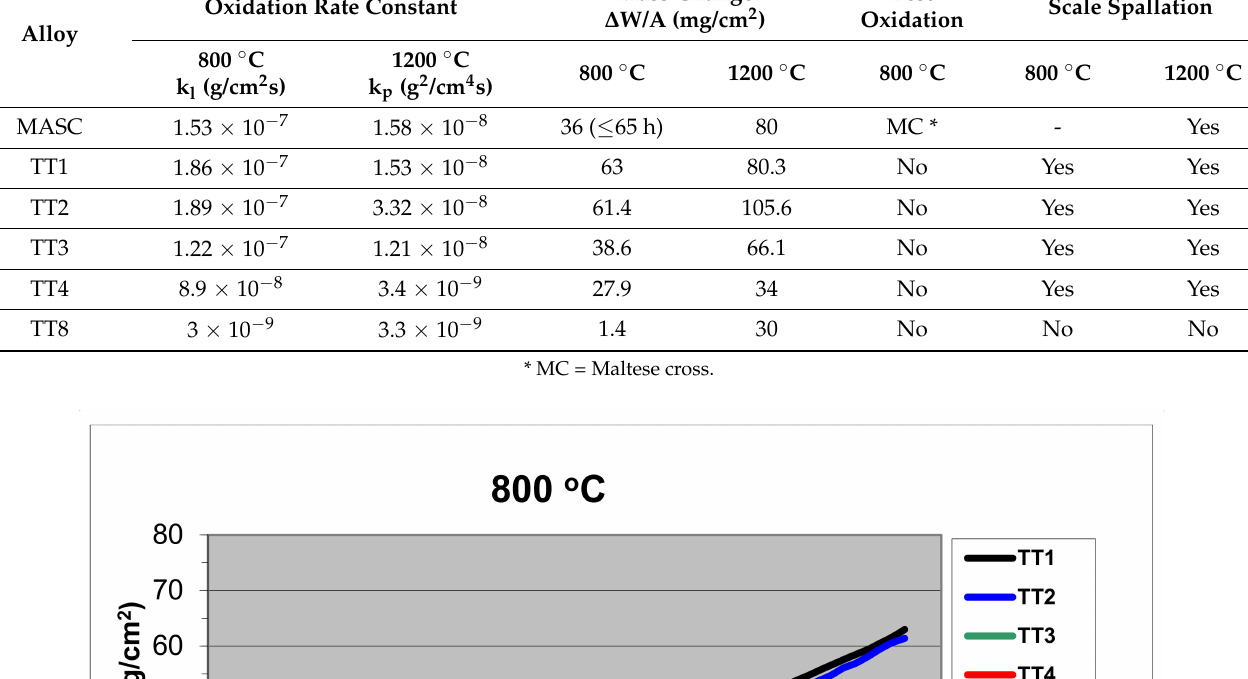
Mass Change Pest Scale Spallation ∆ W/A (mg/cm 2 ) Oxidation